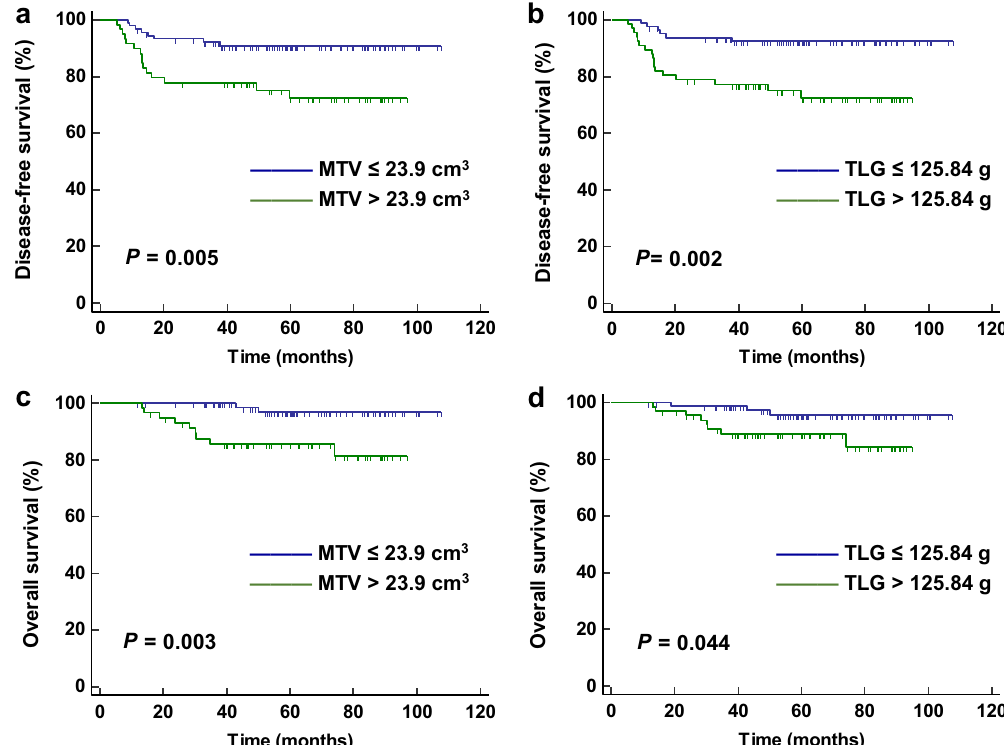
Figure 2. Kaplan–Meier curves for disease-free survival (DFS) and overall survival (OS) according to metabolic tumour volume (MTV) and total lesion glycolysis (TLG). Kaplan–Meier curves for DFS according to MTV ( a ) and TLG ( b ), and Kaplan–Meier curves for OS according to MTV ( c ) and TLG ( d ) in patients with classical rectal adenocarcinoma (n =